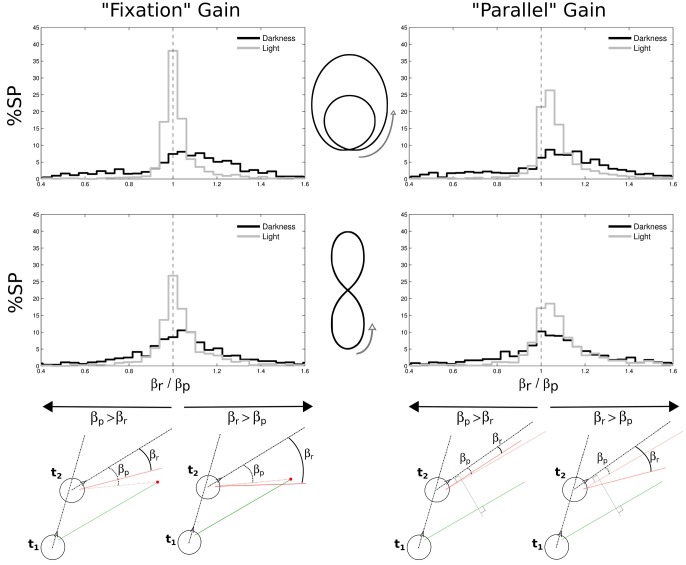
Gains in space of nystagmi slow phases. Two different gains were considered, both in the horizontal plane: a “fixation” gain corresponding to the tendency of gaze during a slow phase to stay aligned with a location on the ground (left part of the figure), and a “parallel” gain assessing the stability of gaze direction in the horizontal plane (right part of the figure). Both gains were computed from a ratio between the real gaze direction (βr, from the head direction) and a predicted gaze direction (βp, from the head direction). The prediction could either be to consider gaze directed toward a point on the ground determined from the previous experimental gaze direction (bottom left) or to consider a gaze parallel to its previous direction (bottom right). A close-to-one gain means that the predicted and real angles were close to each other, as a gain larger than one means that the real angle is wider than the predicted angle. These gains were computed for limaçon (top) and elongated eight (middle) shapes, and separately in darkness (black) and in light (gray). Green and red segments represent gaze direction at the beginning and at the end of a slow phase, respectively.